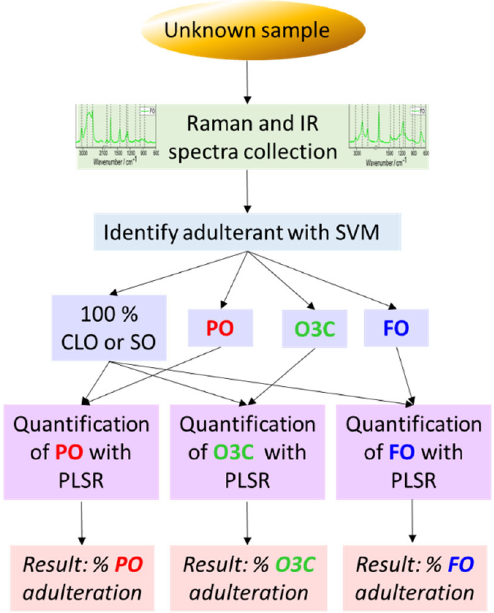
Figure 4. Decision tree/workflow for evaluating unknown samples.